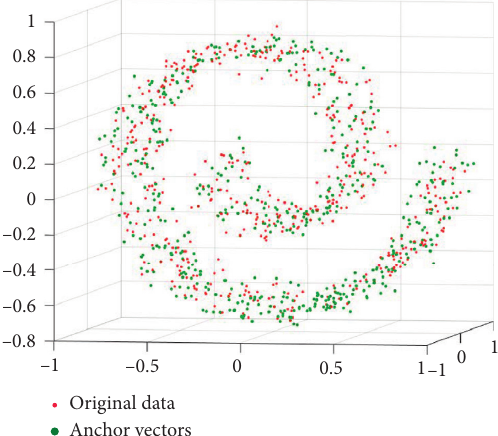
Figure 4: Set of anchor vectors in green